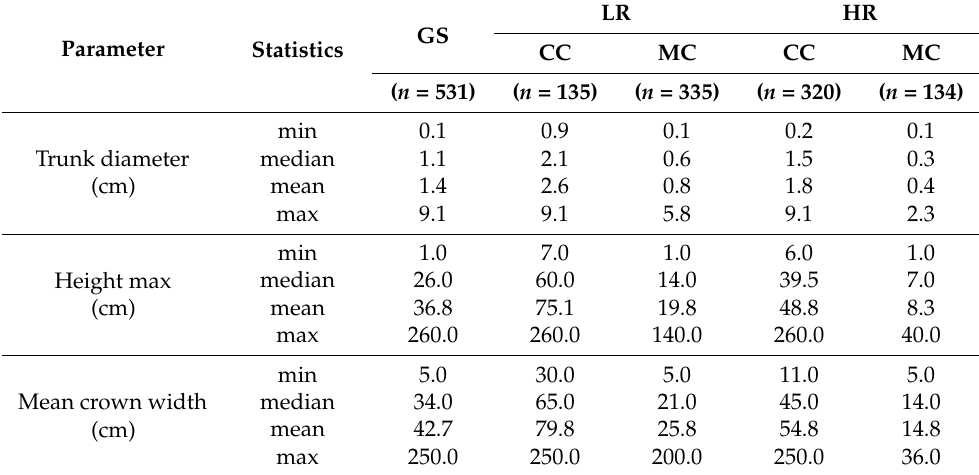
Table 1. Descriptive statistics of the trunk diameter, maximum height and mean canopy width of the ground-surveyed larches (GS), and of the larches correctly classified (CC) and misclassified (MC) through the photo-interpretation of the low-(20 cm; LR) and high-resolution (1 cm; HR) images acquired by drone in mid-October 2018 in an abandoned subalpine grassland subjected to recent